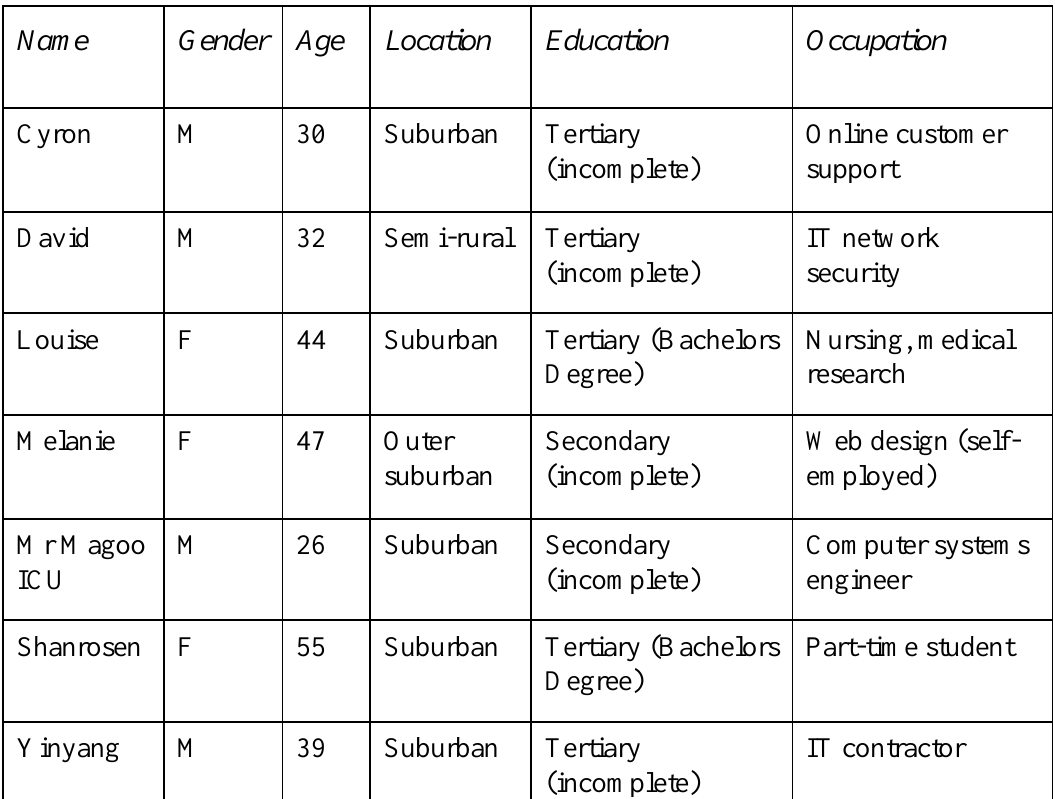
Table 1: Flickr Users